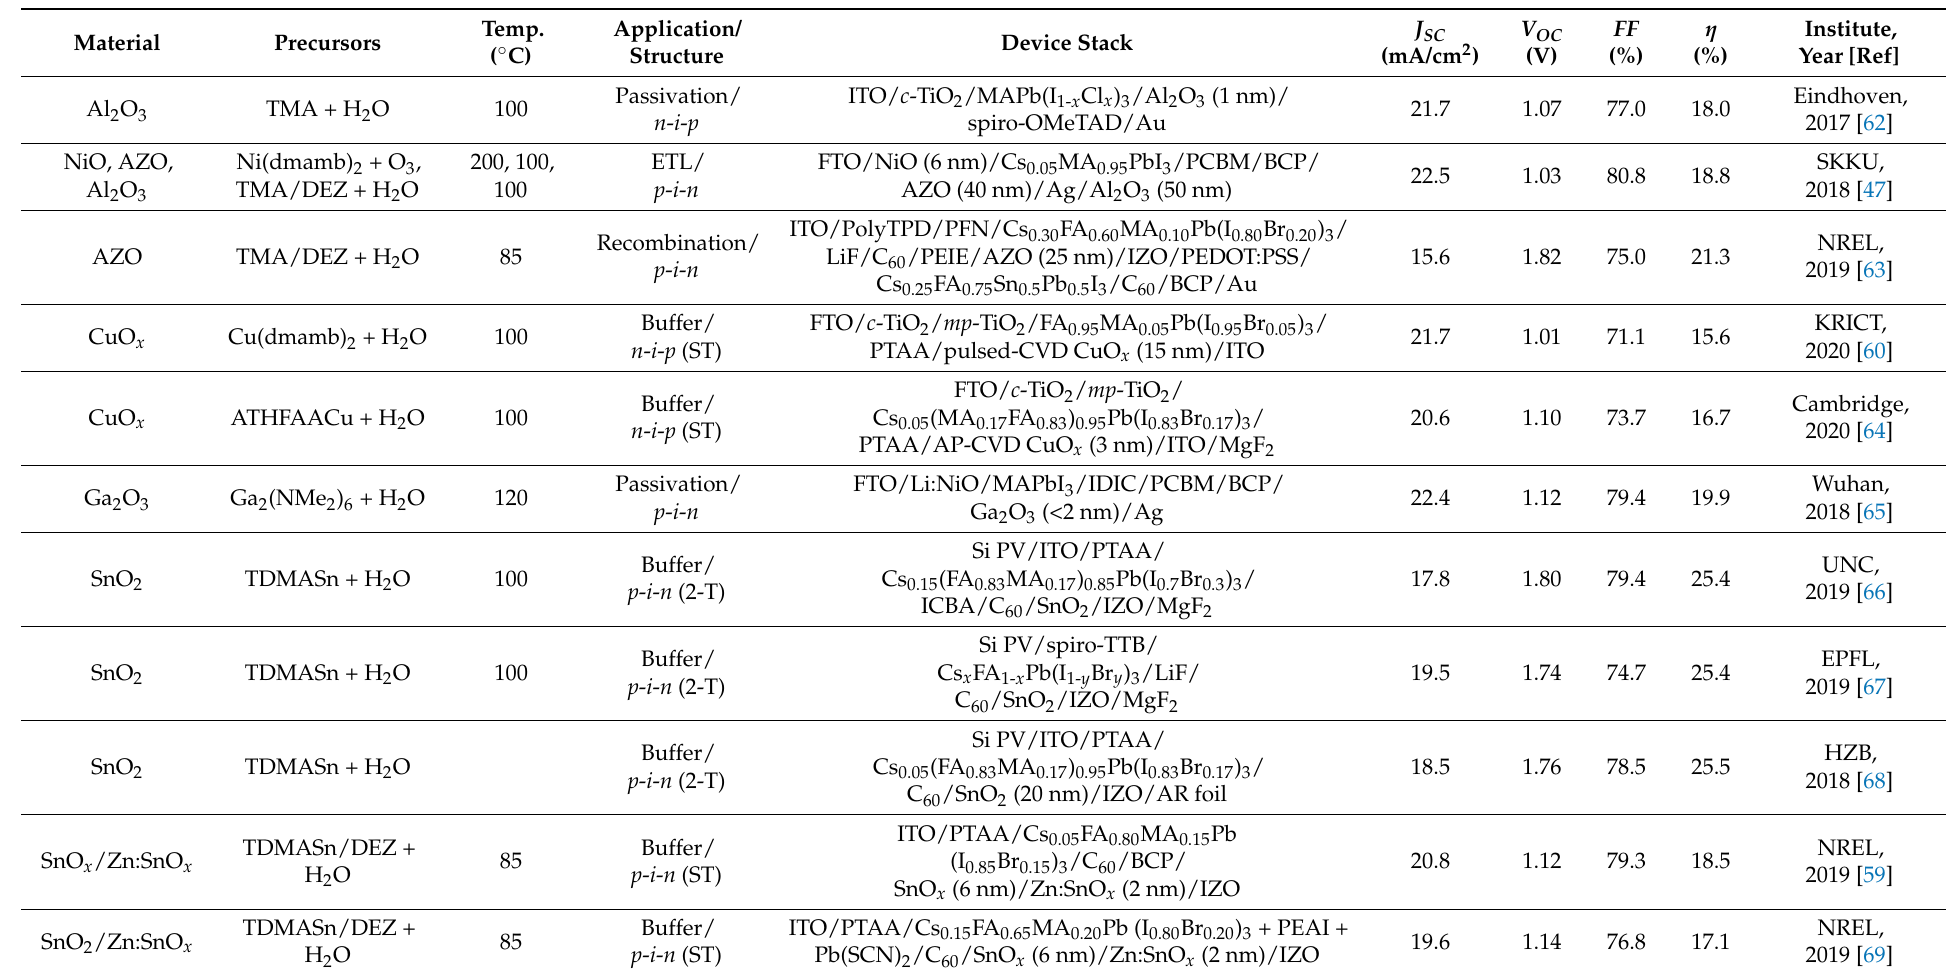
Table 2. Summary of literature on ALD-grown layers above the absorber in perovskite solar